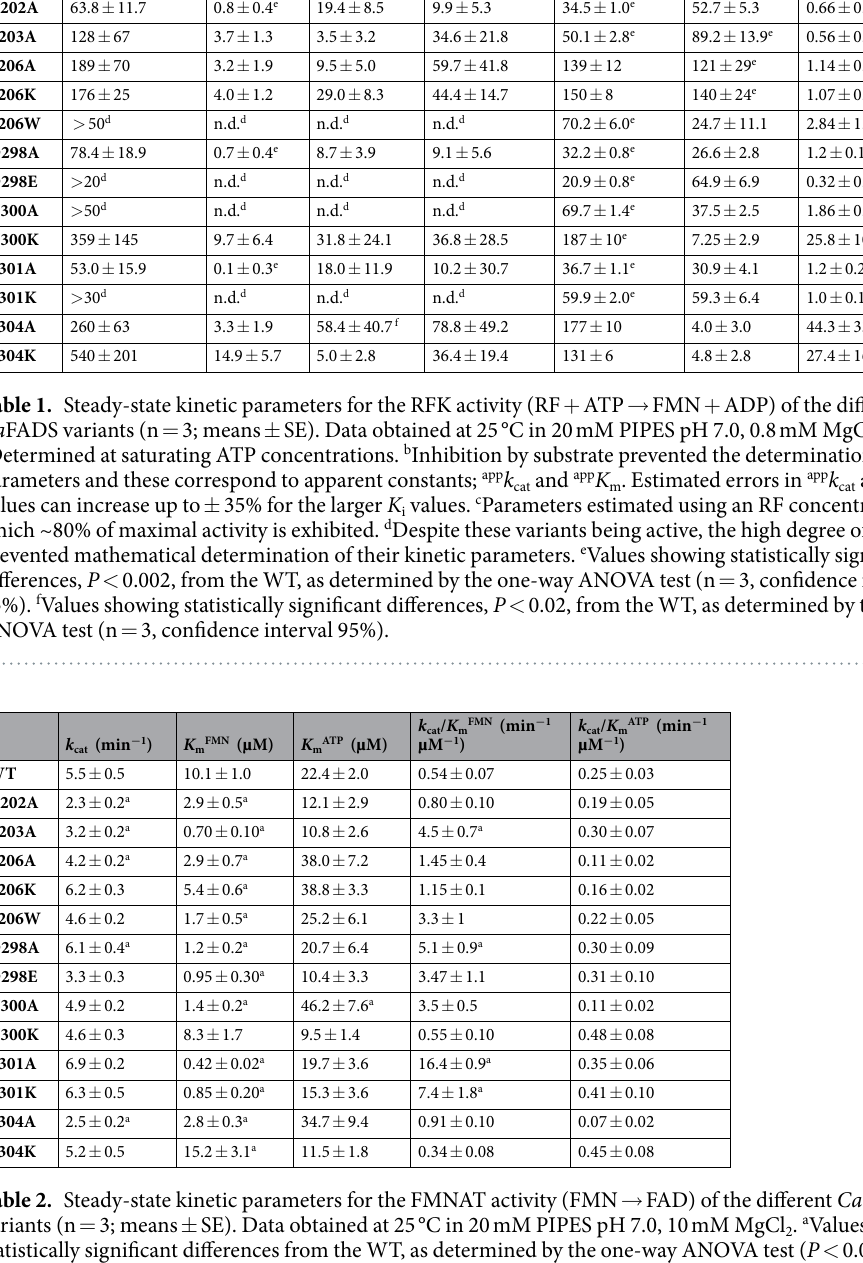
The effects of the mutations on FMNAT activity were similarly evaluated (Table 2). The mutations produced minor effects on the k cat and K mATP values (generally within a factor of two of those of the WT), but decreases in the K mFMN were, in general, more significant (up to 25-fold in the case of E301A). Thus, these variants were more efficient than WT in transforming FMN. These data suggest that mutated residues at the RFK module of Ca FADS modulate the catalytically competent binding of FMN during the FMNAT activity of the enzyme. Ca FADS variants interacting with flavins and ATP. Figure 3). Upon titration with RF, a single binding site was detected for K202A, E203A, F206W, V300A and L304A Ca FADSs. Thermograms for F206A and V300K variants reveal that their interaction with RF, although observed in difference spectra (Figure SP3), is weak or occurs with a very low enthalpy change. The remaining